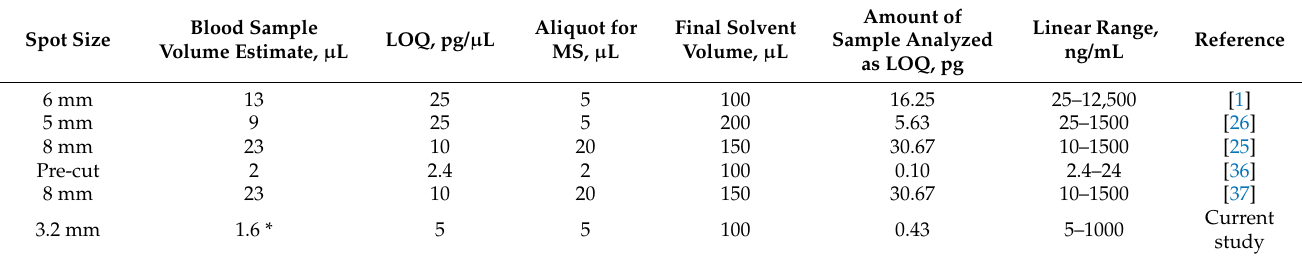
Table 4. Amounts of a sample at the LOQ